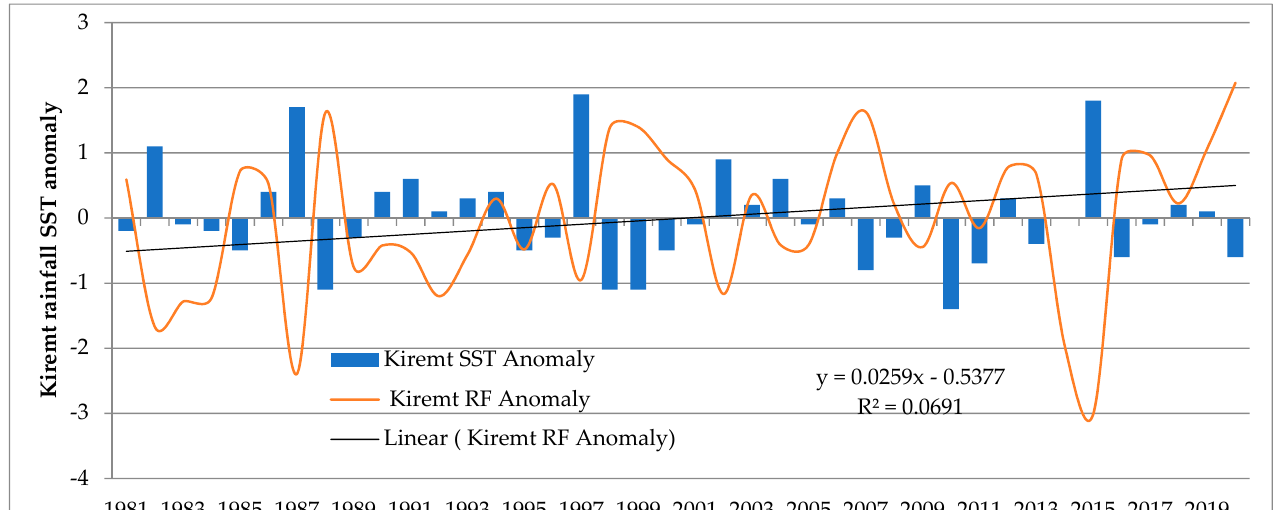
Figure 8. Jemma Belg season rainfall anomaly with Belg SST anomaly using nino 3.4.